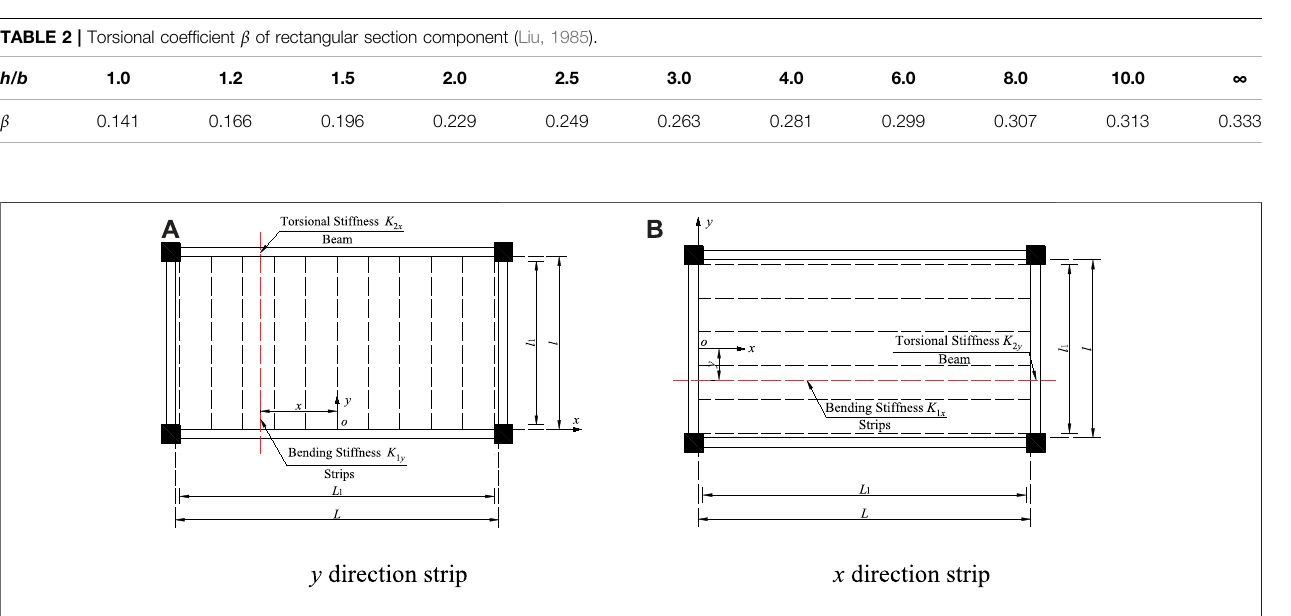
Frontiers in Built Environment |